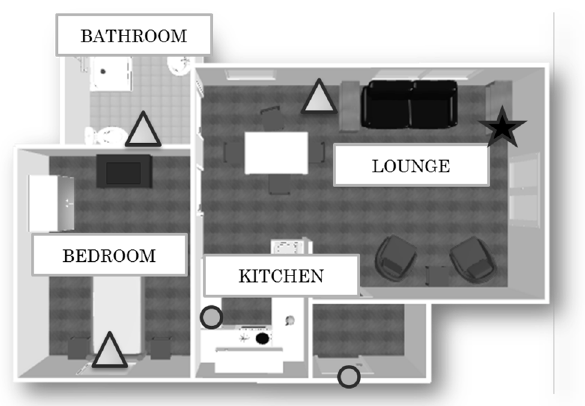
Figure 1. Example of the experimental set-up. The triangles are the Passive InfraRed (PIR) motion sensor, the circles are the fridge door/front door magnetic switch sensors, and the star is the gateway.